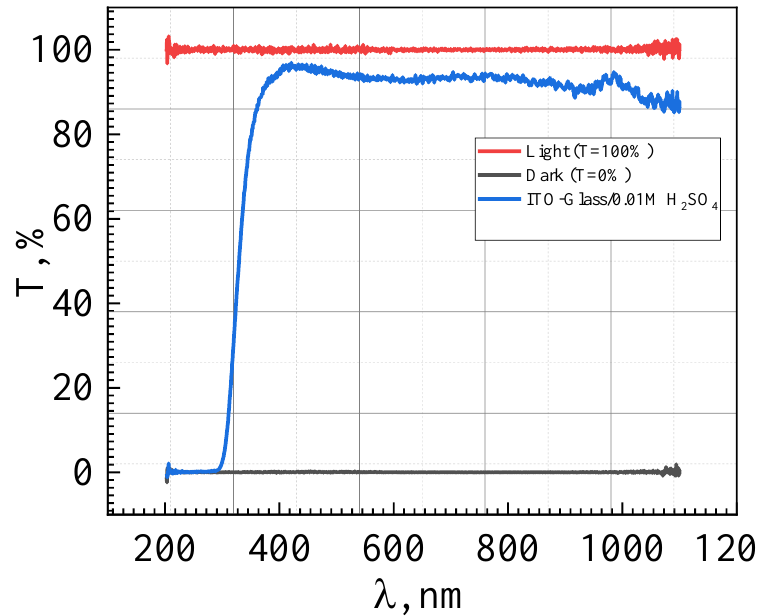
Figure 22. Visible and near-infrared transmission spectra of WO 3 -ITO-glass.